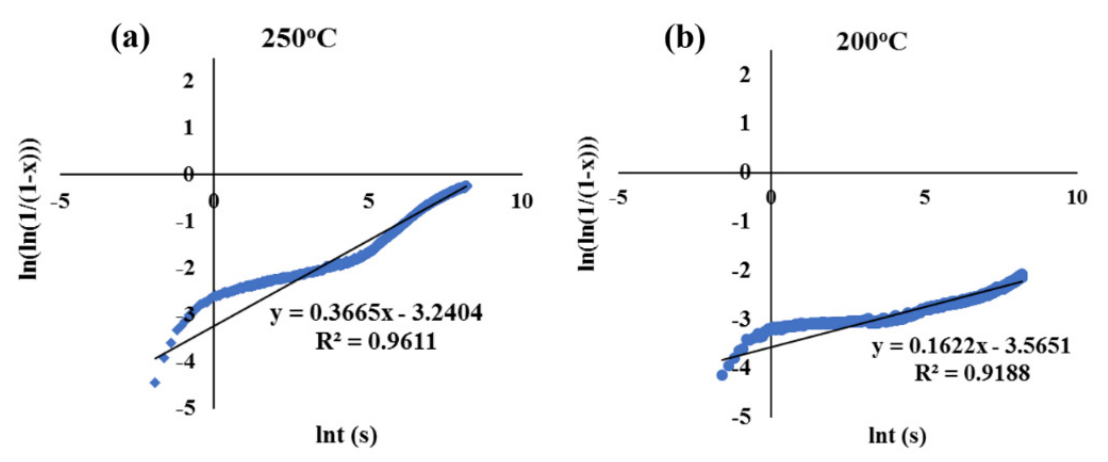
Figure 4. Plots of ln[ − ln(1 − x)] vs. lnt corresponding to dilatation data acquired at various isothermal